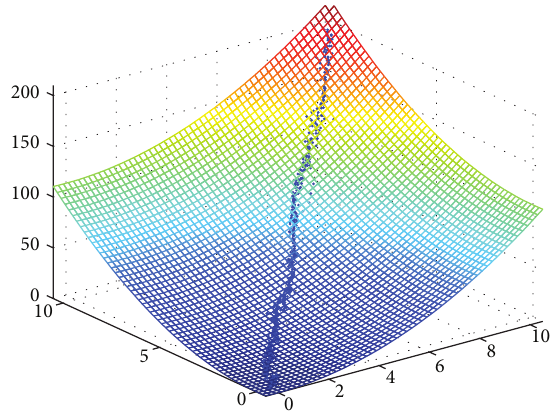
Figure 6: Convergence of exIWO to the optimum of 2-dimensional sphere